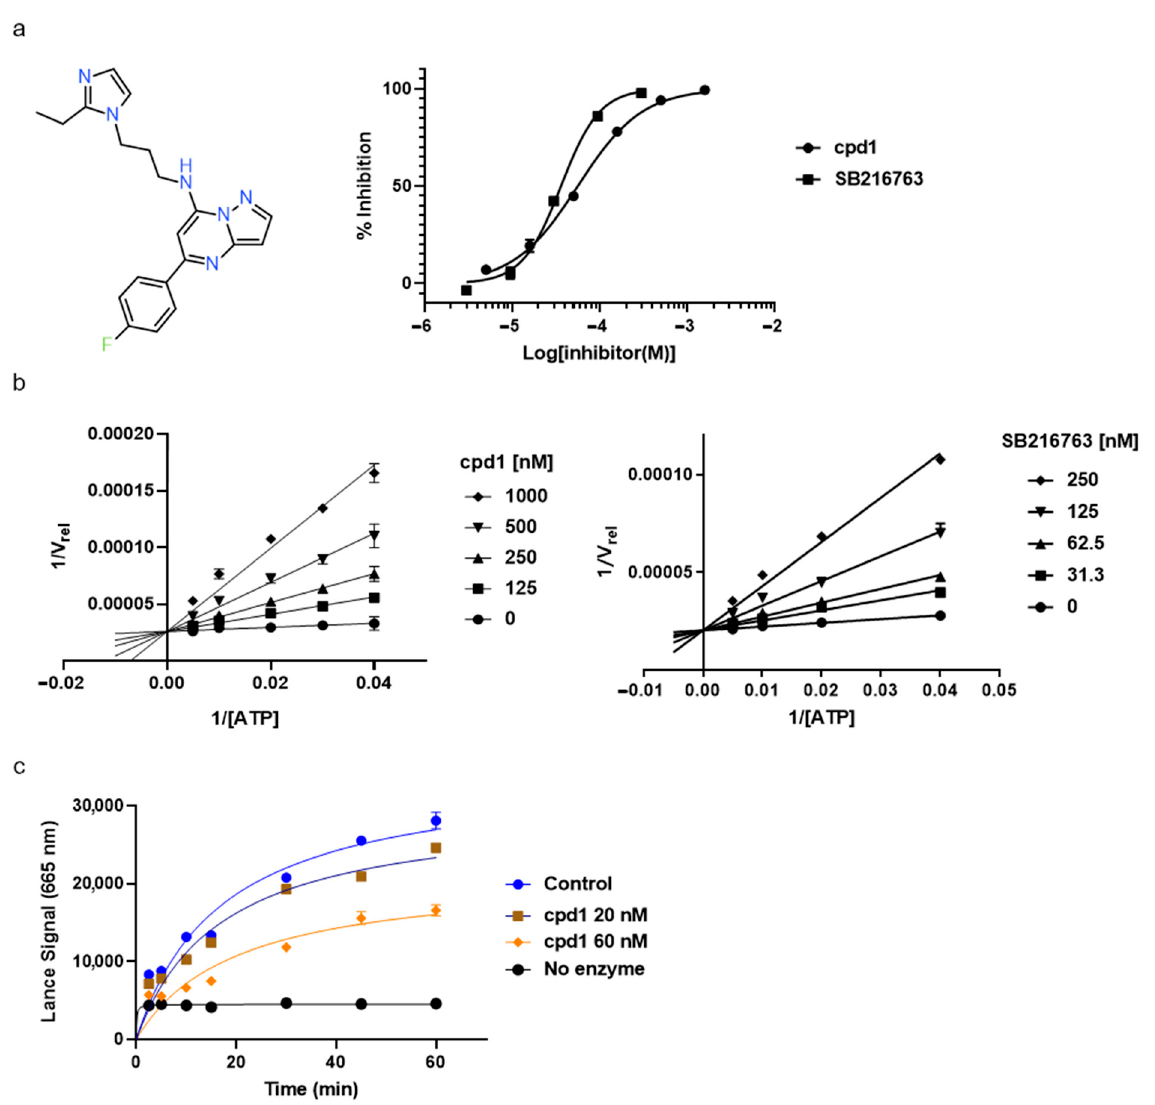
Figure 3. In vitro assay. ( a ) Selected structure of active compound, N -(3-(2-ethyl-1H-imidazol-1- yl)propyl)-5-(4-fluorophenyl)pyrazolo[1,5-a]pyrimidin-7-amine (cpd1) and dose–response curve fit of cpd1 and reference SB216763. ( b ) Competitive inhibition by cpd1 and SB216873. Compounds were tested using 4-point 2-fold serial dilution, starting from 1 µ M or 0.25 µ M at 5 different concentration of ATP (200, 100, 50, 33.3, and 25 µ M). ( c ) Reversibility test. GSK3 β enzyme was pre-incubated with 1 µ M (>20-fold of IC 50 ) cpd1 for 30 min and diluted with buffer into indicated concentra- tions.